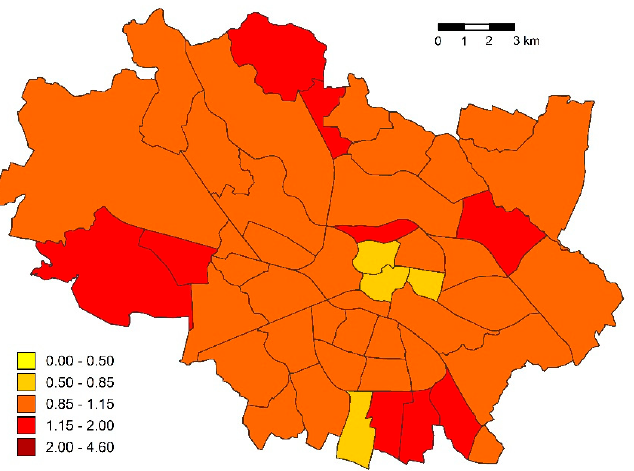
Figure 8. Concentration of medium-low-technology industrial entities in the housing estate of